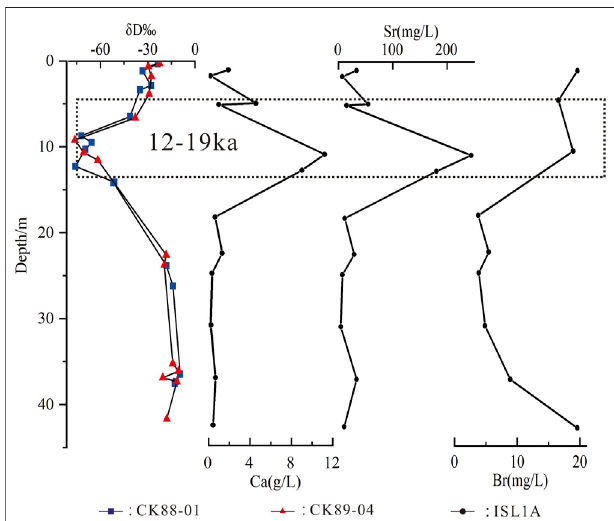
FIGURE9| ComparisonoftheCa 2+ ,Sr 2+ ,andBr − changetrendofhalite fl uid inclusions in the ISL1A borehole and δ D change trend of halite fl uid inclusions in CK88-01 and CK89-04 boreholes (the δ D data from Zhang et al.